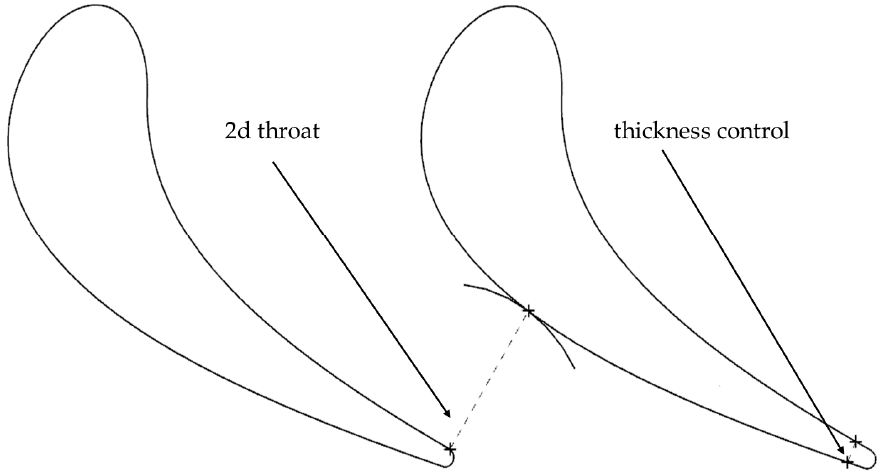
Figure 6. 2D section of two adjacent components with throat and thickness control